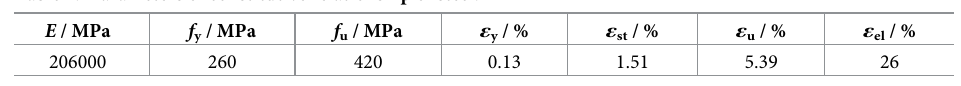
Table 2. Parameters of constitutive relationship of steel.